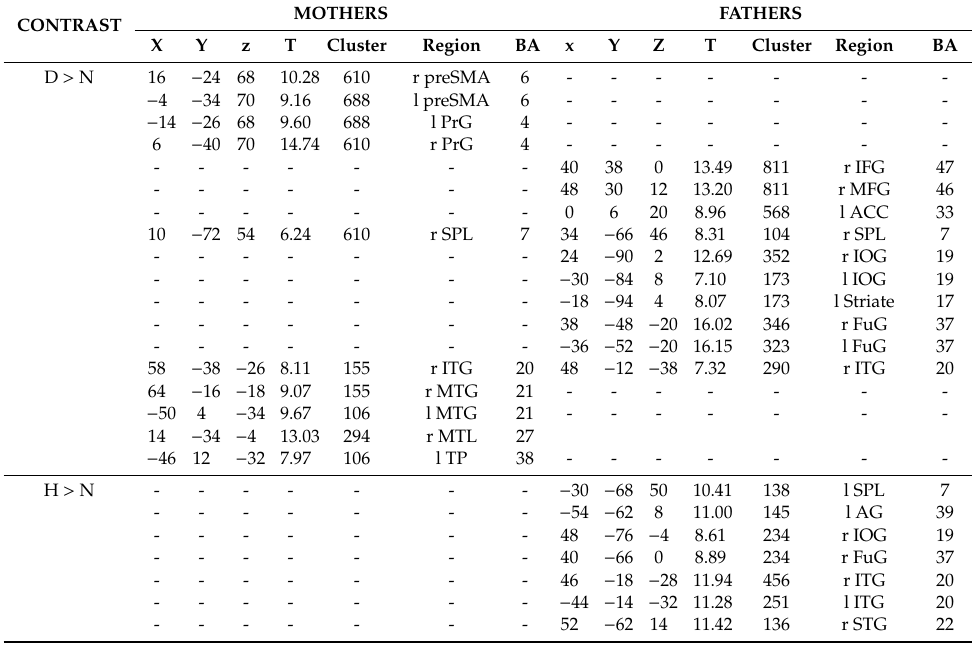
Table 1. Cerebral regions in which activity was higher in response to infant emotional faces than in response to neutral